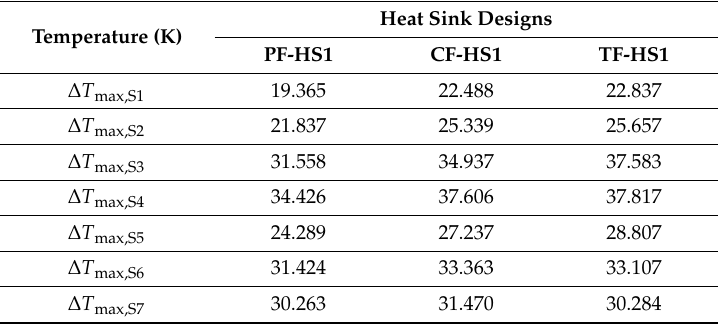
Figure 6. Temperature contours at the base ( y / L y = 0) and at the middle height ( y / L y = 0.5) of the heat sinks without hotspots at total flow rate of 0.01 kg/s: ( a ) PF-WHS; ( b ) CF-WHS; and ( c ) TF-WHS. Table 8. Total thermal resistances and maximum temperature increases at the hotspots of the PF, CF, and TF heat sinks for the hotspot scheme HS1 at the total flow rate of 0.01